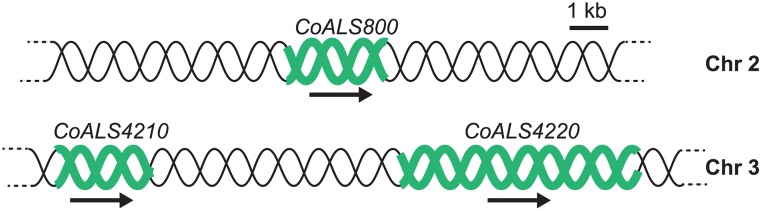
Schematic of CoALS genes.Analysis reported here indicated that C. orthopsilosis strain 90–125 encoded three ALS genes (in green), namely CoALS800 (2499 bp) located on chromosome 2, and CoALS4210 and CoALS4220 (2457 bp and 6078 bp, respectively), which were contiguous on chromosome 3 and separated by 6321 nt. The scheme was drawn to scale. An arrow below each gene indicates the orientation of the ORF.